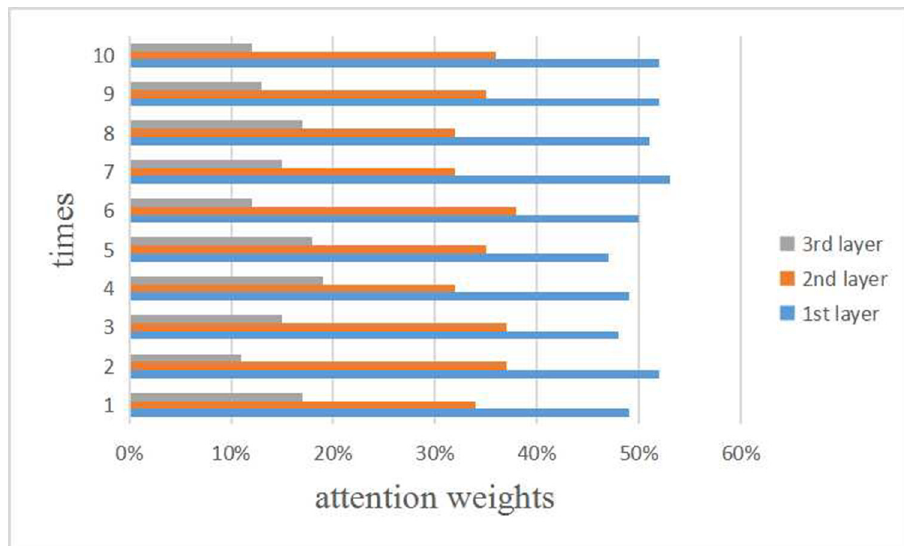
Fig 9. Attention weights for three convolution layers in GCAEMDA.